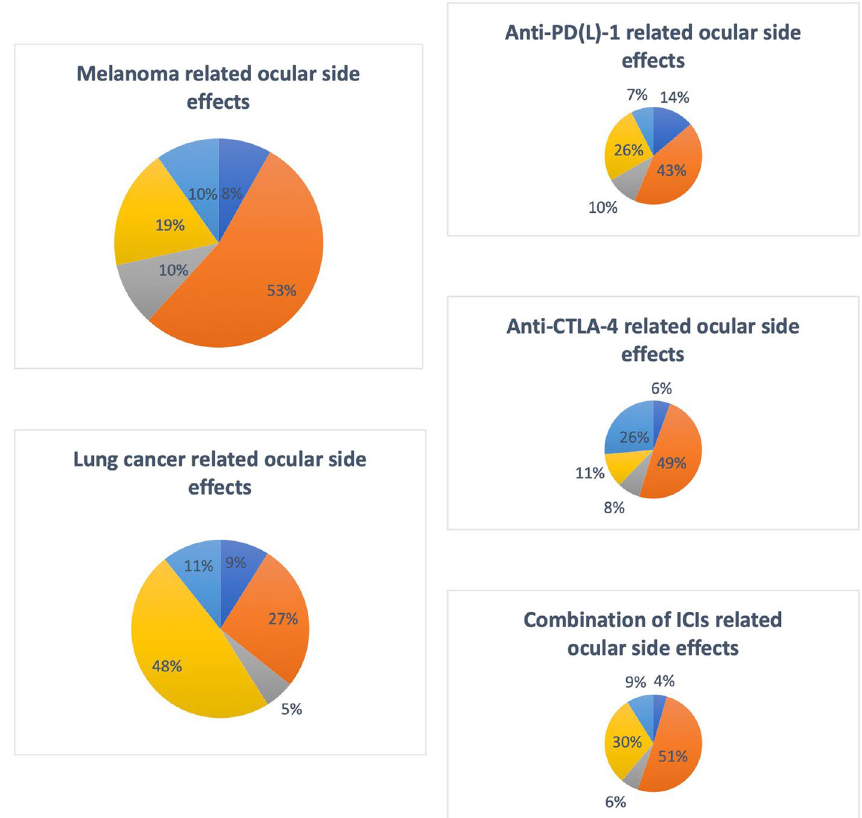
Fig. 5 Reported ocular side effects according to the primary tumor / ICI